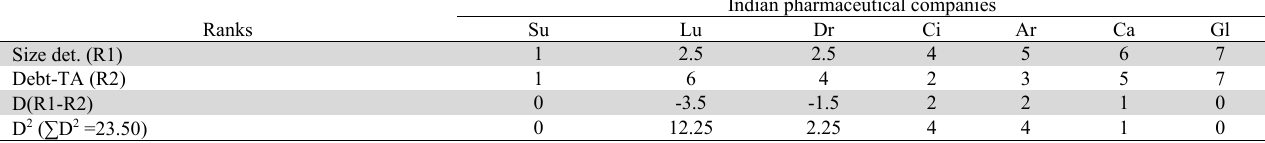
Originating Source: R1 and R2 from Table 1 and Table 9.